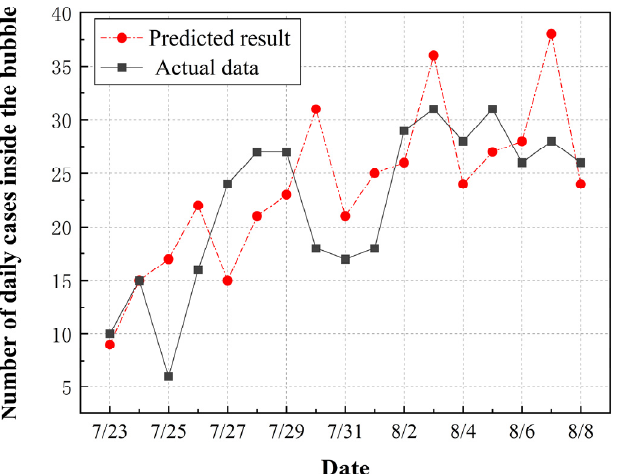
Figure 4. Comparison between predicted results and actual data for daily new cases among Olympic-